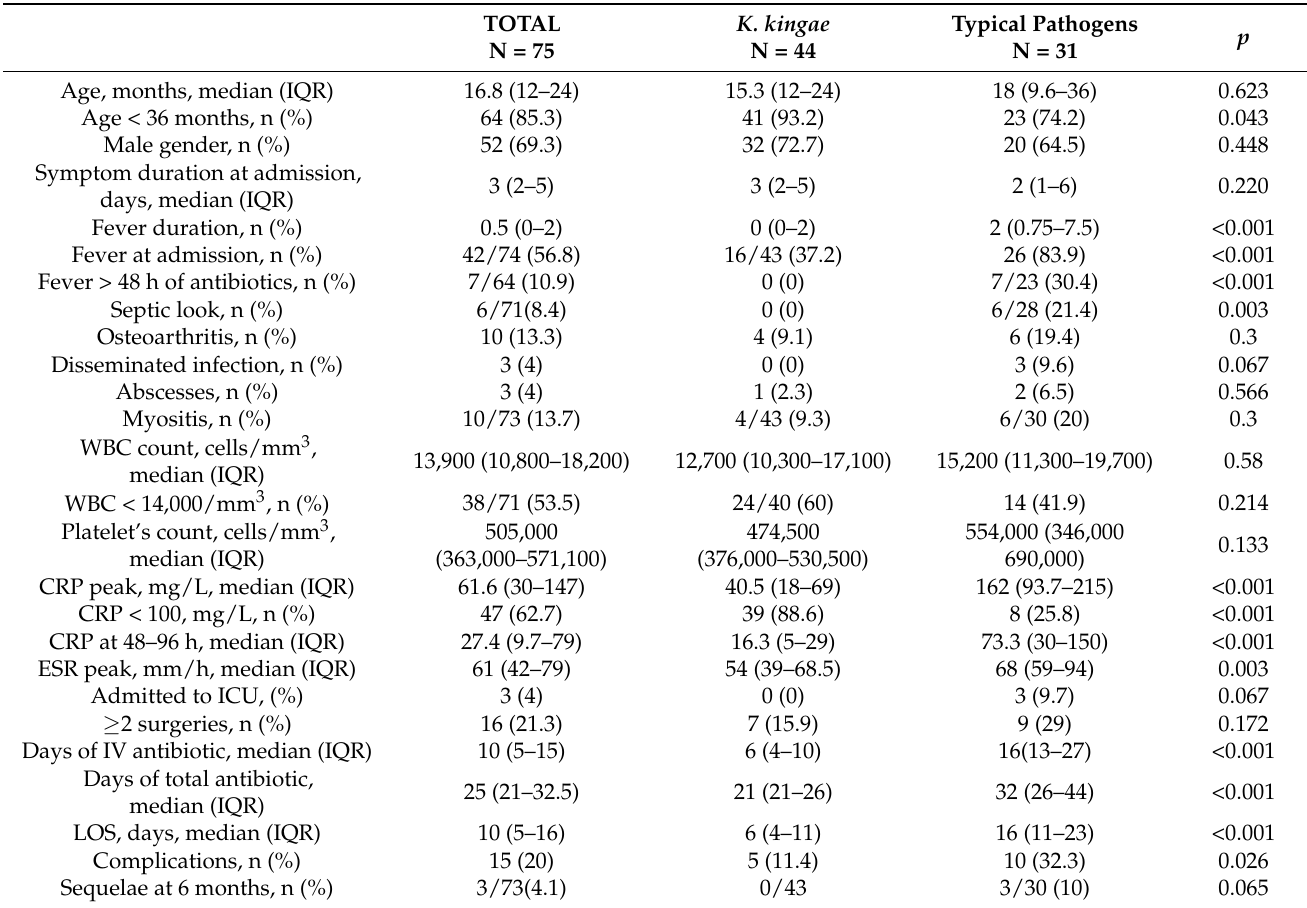
Table 1. K. kingae and typical pathogen arthritis in children < 5